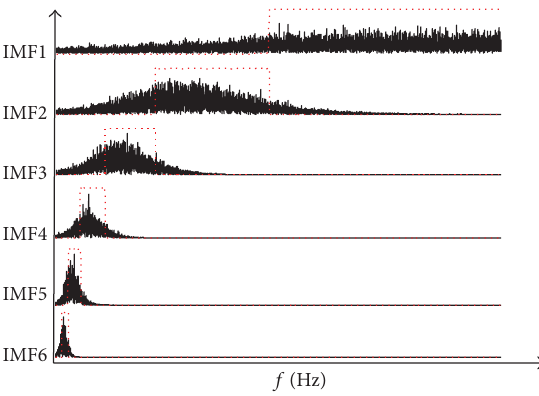
Figure 1: Construction sketch of filters based on